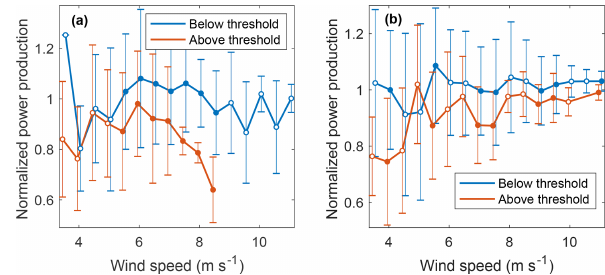
Figure 15. Mean normalized power production (turbines A–D) of observations above and below the α/β threshold for speed shear between 0.2 and 0.3 (a) and between 0.4 and 0.5 (b) . Filled circles are statistically distinct. Error bars represent 1SD from the mean.